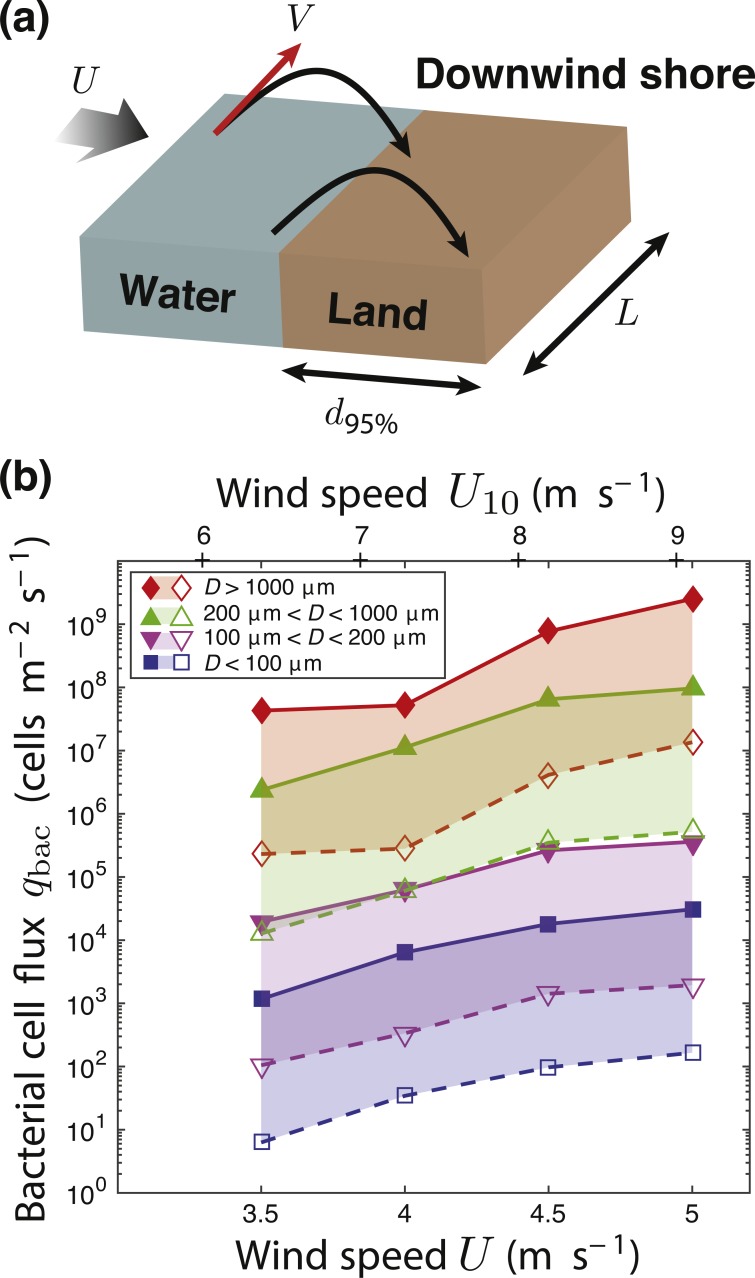
Splash zone.(A) The width of the ‘splash zone’, that portion of the downwind shore adjacent to the body of water that will receive locally released droplets, can be estimated as d95%, the distance from the shoreline where 95% of the total mass transferred from the water to the land is reached. (B) The potential for bacteria to move across the air-water interface, given as a bacterial cell flux, qbac, based on the droplet mass flux at four wind speeds (reported as U at 2.5 cm and U10 at 10 m) and at four different droplet size ranges, using the reported bacterial concentrations from literature for freshwater lakes (Bird & Kalff, 1984; Coveney, 1982; Field et al., 1980). For each diameter range, the filled symbols correspond to the high estimate of 1.3 ×107 cells/mL and the open symbols correspond to the lower estimate of 7.2 ×104 cells/mL, with the region between shaded.